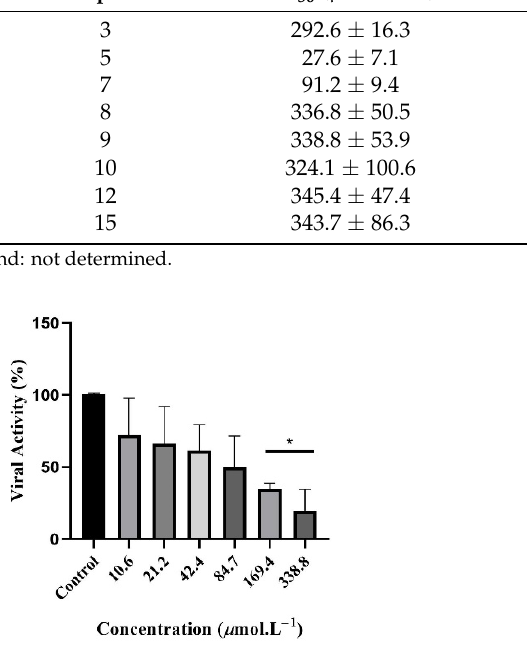
Table 2. Cytotoxic concentration (CC 50 ), effective concentration (EC 50 ), and selectivity index (SI). Compound